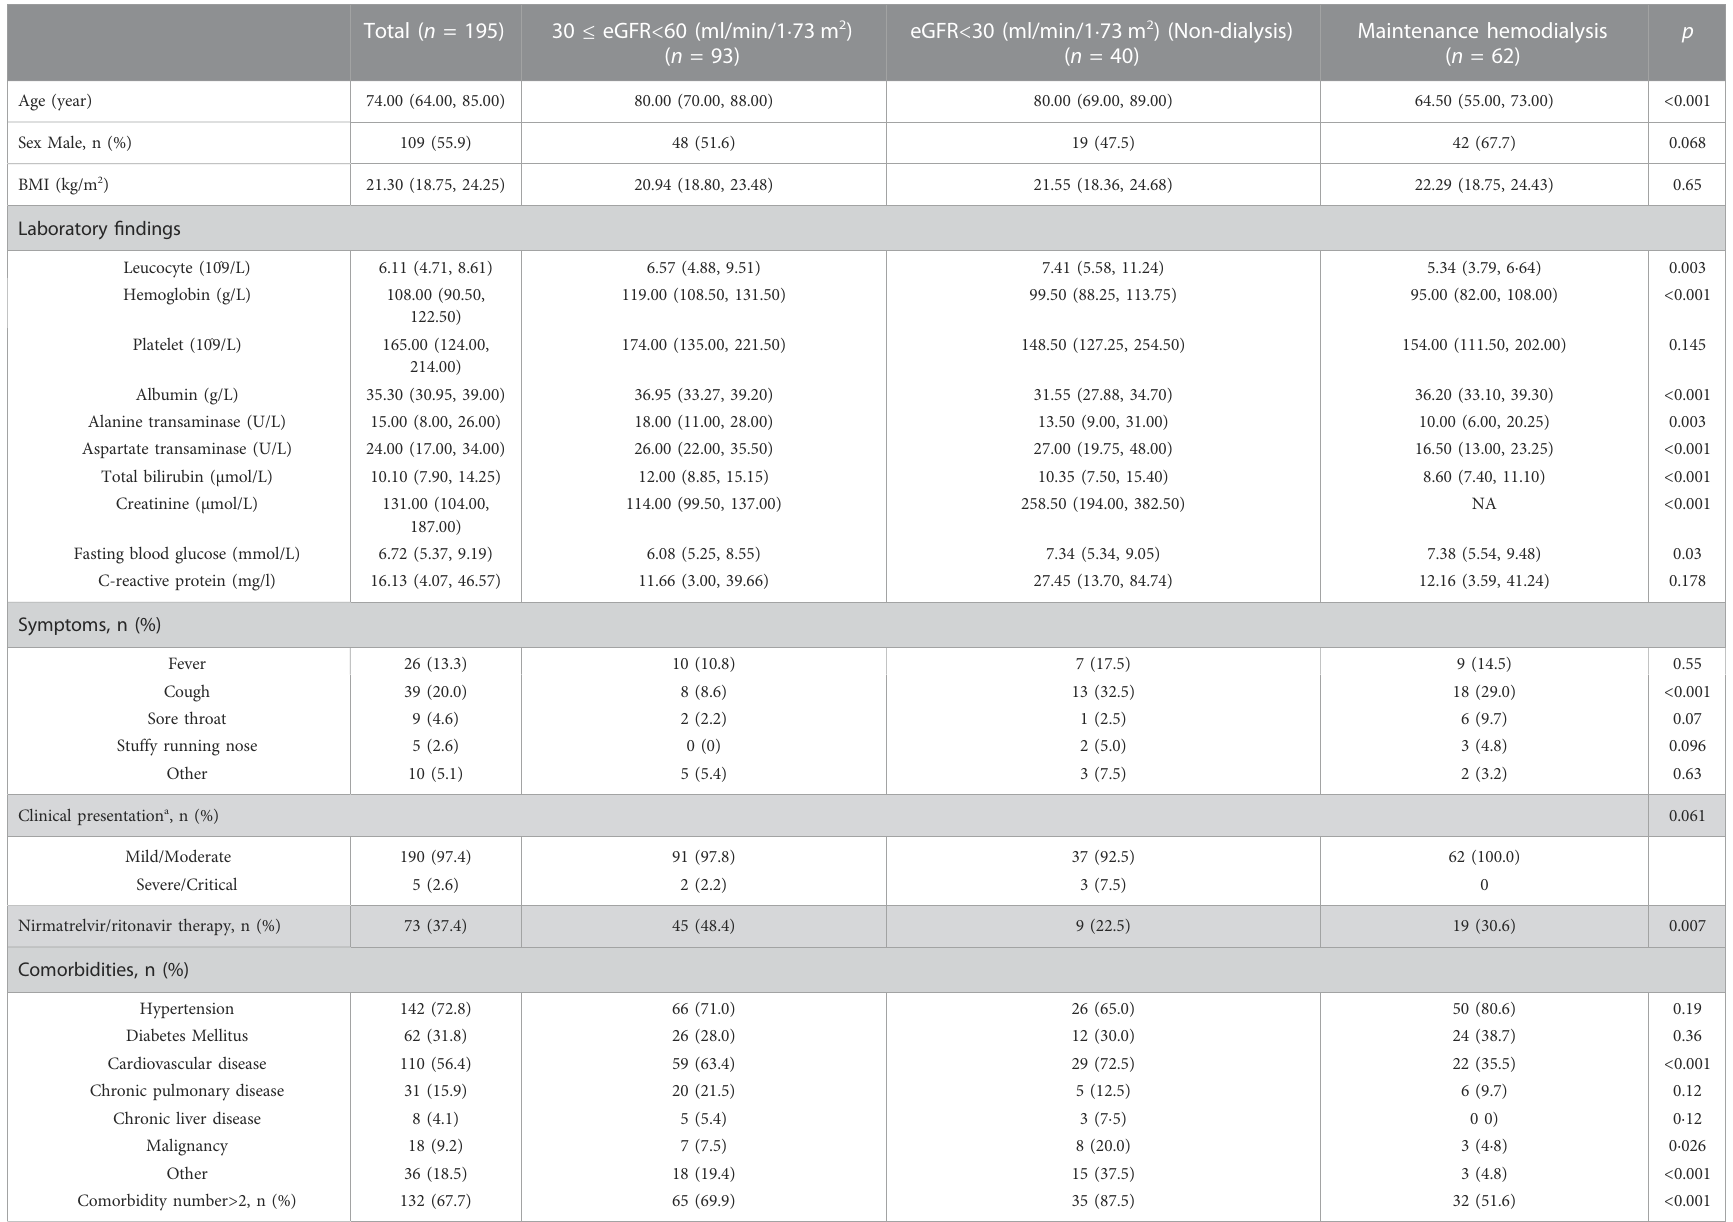
TABLE 1 Baseline characteristics of patients with SARS-CoV-2 infection and impaired kidney function, according to eGFR